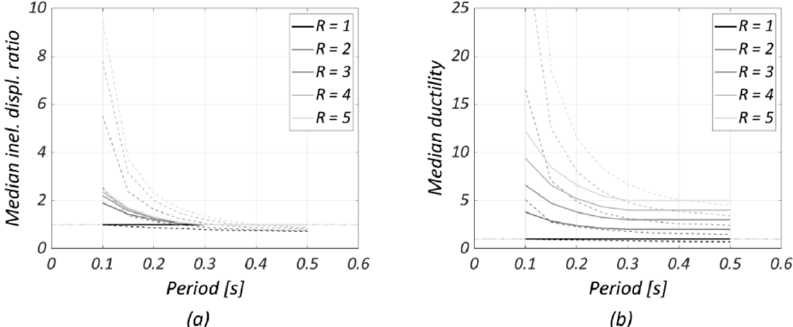
Figure 9. Comparison between the predictions by the N2 method (solid lines) and the results from NLTHA of Suite 2-A (dashed lines): ( a ) median C R − R − T curves, and ( b ) median µ R − R − T curves.